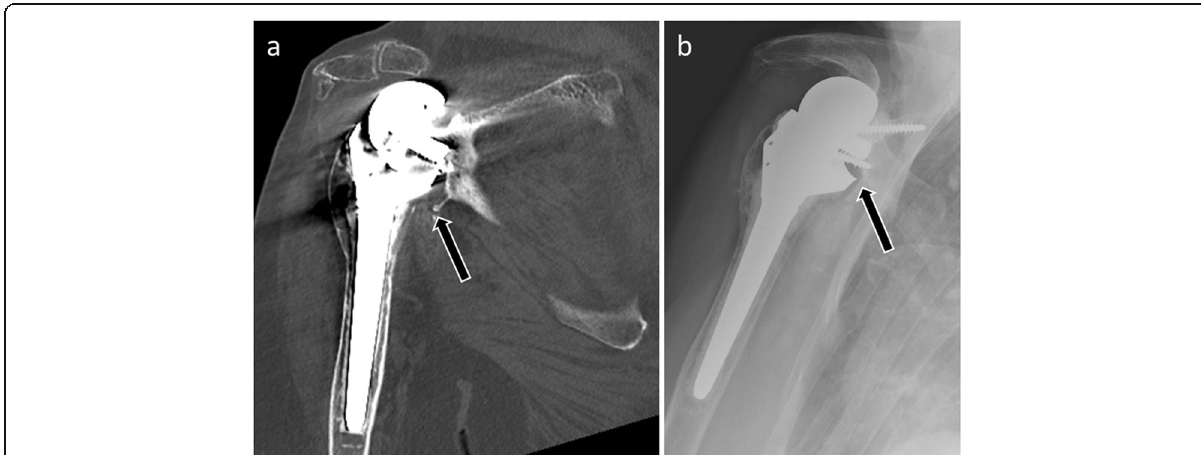
Fig. 13 Coronal CT image ( a ) and anteroposterior radiograph ( b ) of an 89-year-old patient with painful reverse shoulder arthroplasty show scapular notching manifested by bone resorption of the inferior scapular border (arrows)